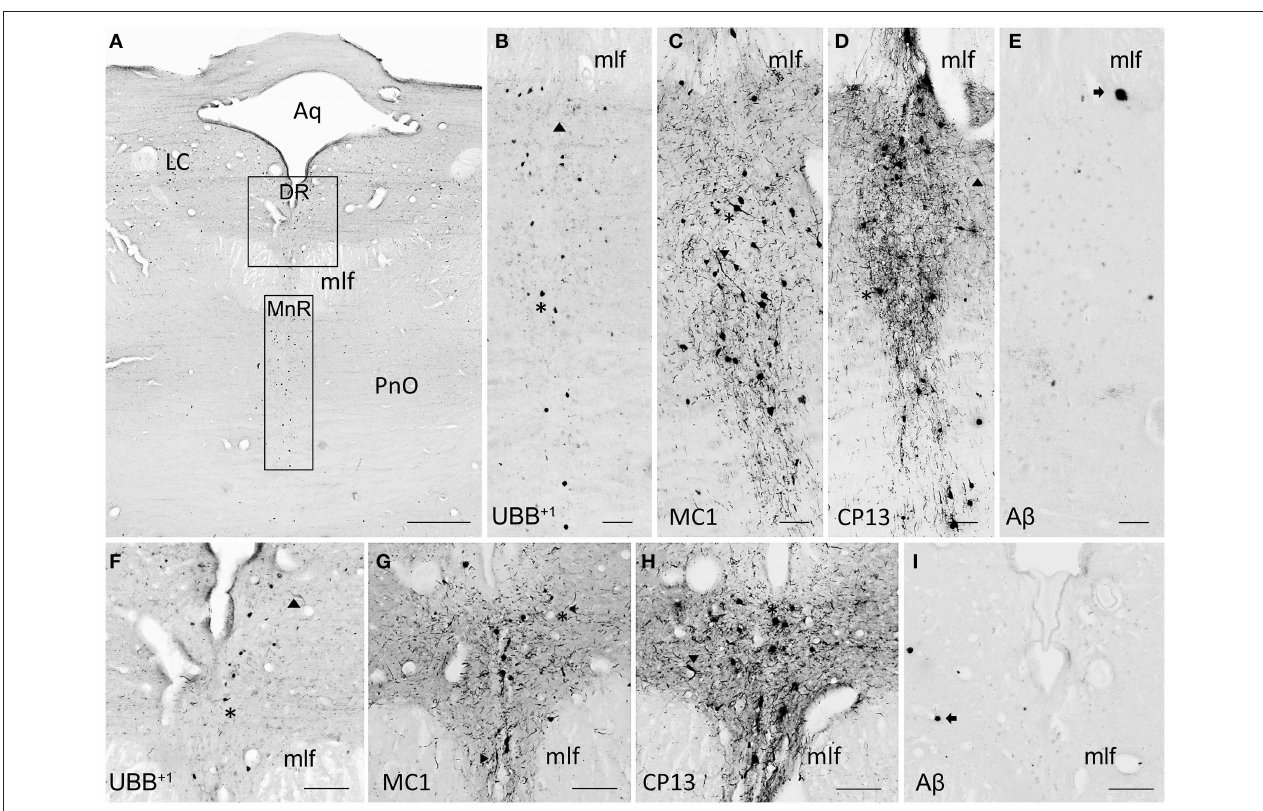
6F3D. The raphe nuclei located in the rostral brainstem (MnR and DR) express selective vulnerability to tau pathology ( asterisk , neuronal staining; filled triangle, NTs), being almost devoid of plaques (arrow ). Both MnR and DR are strongly stained by antibodies directed against pre-tangle material (MC1) and NFTs (CP13), and present a moderate number of UBB + 1 -positive substrates (asterisk) . Bars: (A) , 1mm, (B–I) , 200 µ m. Aq, cerebral aqueduct; DR, dorsal raphe nucleus; LC, locus coeruleus; mlf, medal longitudinal fasciculus; MnR, median raphe nucleus, PnO, pontine reticular nucleus oral